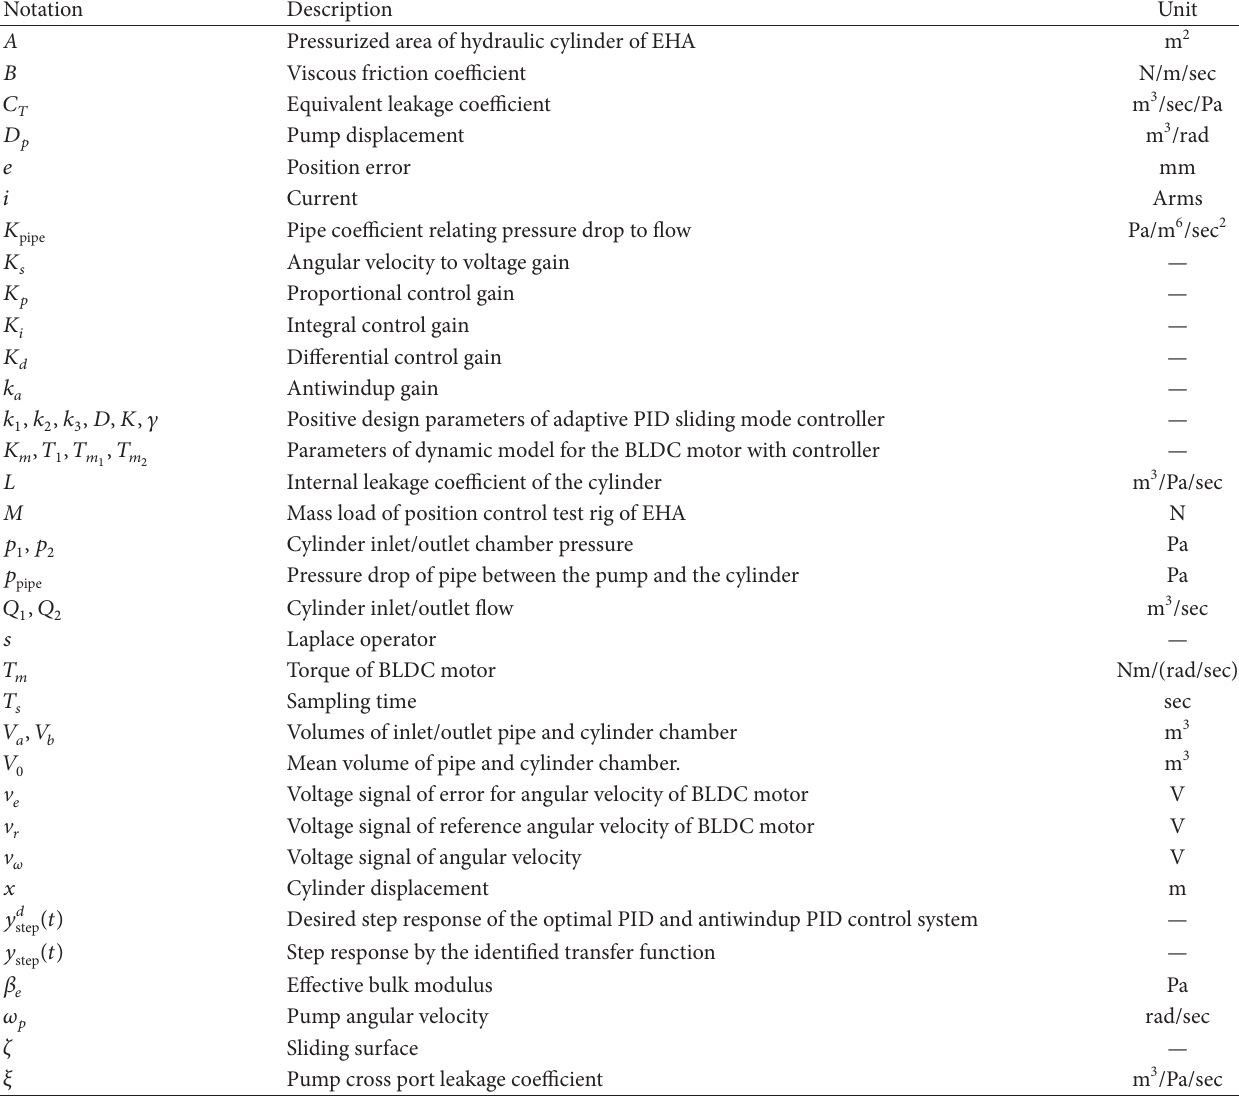
Table 6: List of